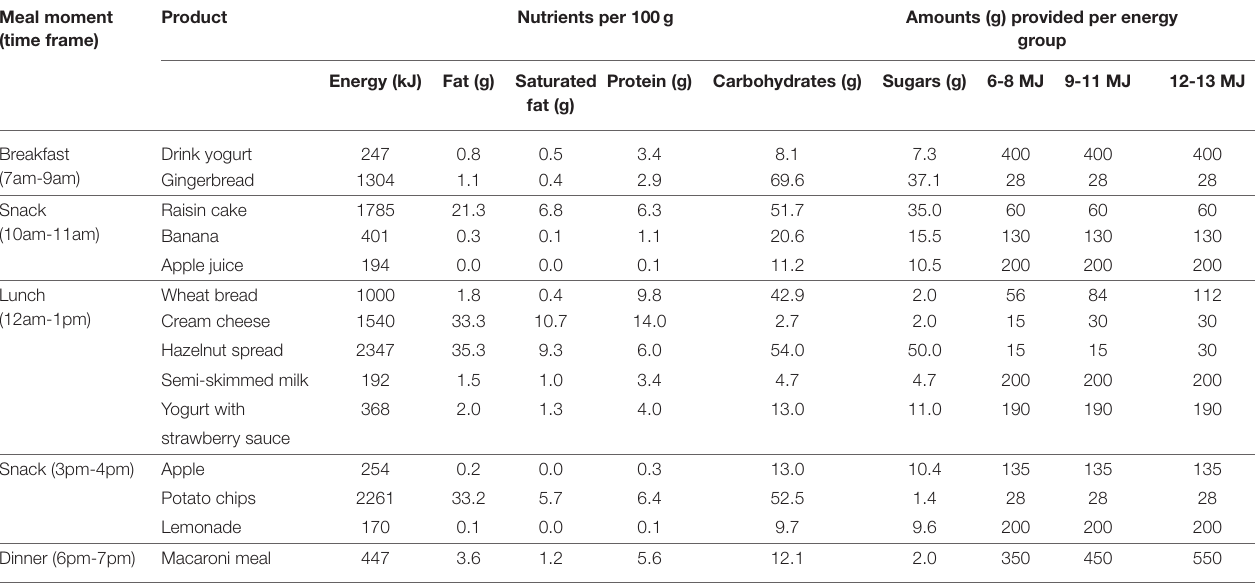
Supplementary Table 3 | Overview of standardized products provided during at-home days and amounts provided per energy group. Meal moment (time frame)